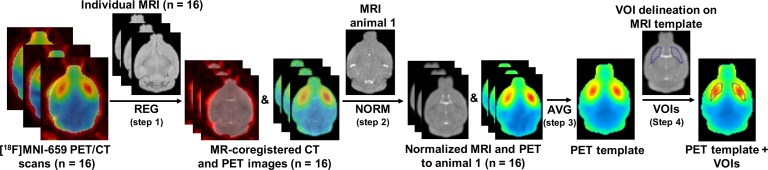
Creation of [18F]MNI-659 brain PET template in standardized MR space and VOI delineation.First, static [18F]MNI-659 PET images covering the whole scan duration (i.e. 90 min) were generated. Static PET images and the corresponding CT images were co-registered through rigid body transformation to their individual MRI (REG, Step 1) based on CT to MR transformation. Following this step, MRI and PET images were then normalized to the MRI of the first animal through a non-linear warping registration (NORM, Step 2) and were visually inspected for accuracy. Next, the static PET images were averaged in order to obtain the [18F]MNI-659 PET template (AVG, Step 3). The averages of all MR images normalized to the first animal were used to generate the MRI template and to delineate manually the VOIs (i.e. striatum and cerebellum). The PET template corresponds and is spatially registered to the MRI template, thus the VOIs defined on the MRI template can be also used in the PET template (Step 4). Unmasked PET images were used for both spatial normalization approaches, however, for visual clarity, masked images are shown. Only data from the WT animals were used. REG = registration, NORM = normalization, AVG = average, WT = wild-type, HET = heterozygous.